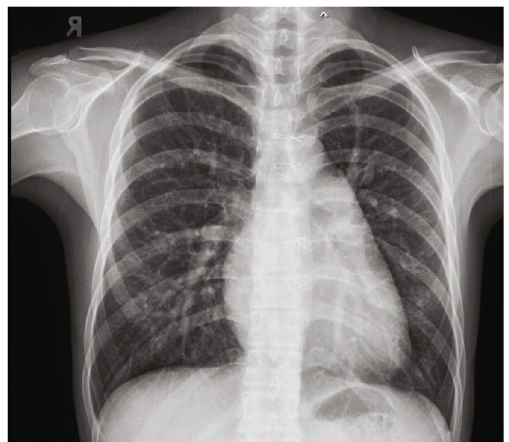
Figure 1: Plain radiograph of the chest showing mild cardiomegaly with left atrialization and slight increase in pulmonary blood fl